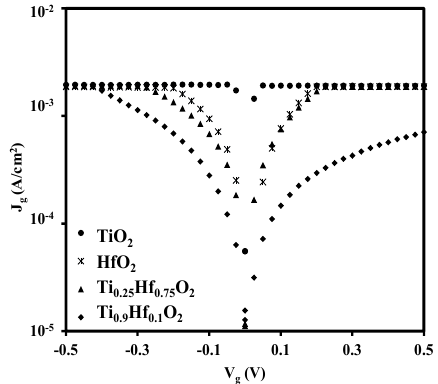
Figure 9. Gate leakage current density ( J g ) versus gate voltage ( V g ) for samples of HfO 2 , Ti 0.25 Hf 0.75 O 2 , Ti 0.9 Hf 0.1 O 2 , and TiO 2 . The titanium oxide occupies the highest leakage current level followed by hafnium oxide and Ti 0.25 Hf 0.75 O 2 thin films with similar leakage current levels. The Ti 0.9 Hf 0.1 O 2 sample has the lowest leakage current.